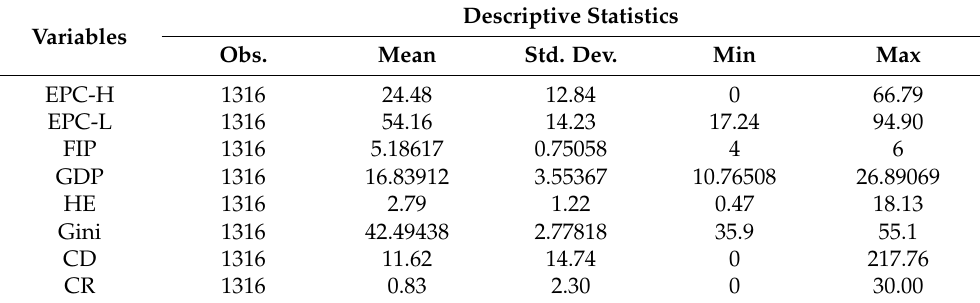
statistically signi fi cant. High energy performance certi fi cates positively correlate with FIP, HE, CD, and CR, while their correlation with EPC_L, GDP, and the Gini coe ffi cient is negative. Low energy consumption performance certi fi cates are negatively correlated with all the variables. Table 4. Correlation coe ffi cients. Variable